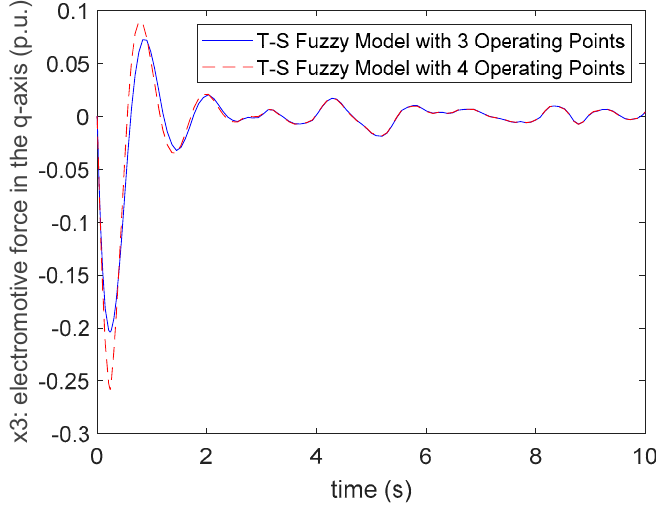
Figure 5. The comparisons of state x ( t ) responses for Case 1.